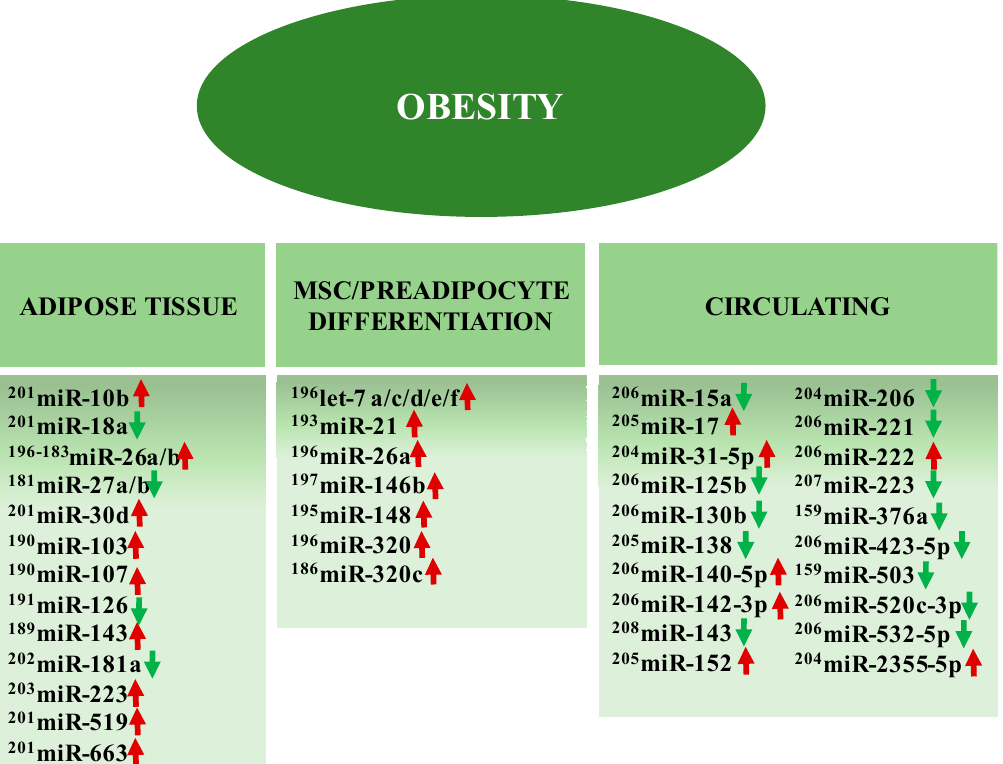
Figure 3. The dysregulated miRNA profile in obesity. The diagram shows the miRNA expression pattern found in the adipose tissue and during MSC/preadipocyte differentiation. Circulating miRNAs evaluated in serum, plasma, whole-blood, or mononuclear cells, in clinical studies, are also listed. ↑ = upregulated, ↓ = downregulated.